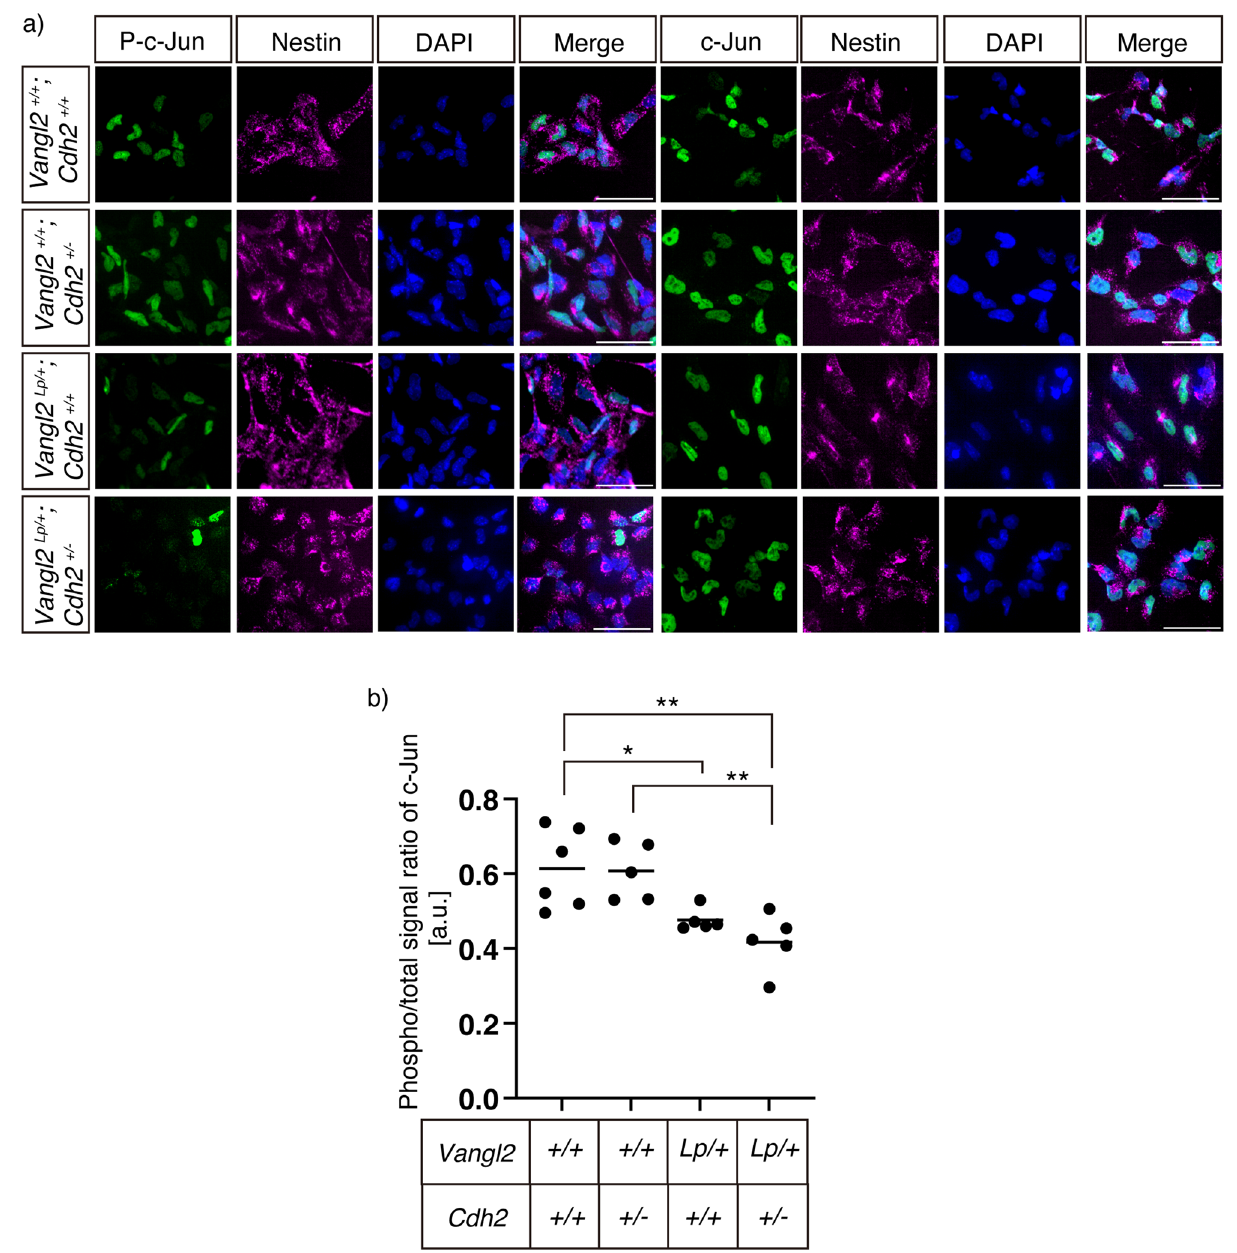
Figure 5. JNK signaling activity in neuroepithelial cells. ( a ) Immunofluorescence analysis of the primary neural tube cells derived from E9.5 embryos with the indicated genotypes. Cells were immunostained with either a combination of anti-phospho c-jun (green) and anti-Nestin (neural cells; magenta) or anti-c-jun (green) and anti-Nestin (magenta). Nuclei were stained with DAPI (blue). ( b ) Point graph showing ratio of immunofluorescent signals of phosphorylated c-Jun to those of the total in the Nestin-positive neuroepithelial cells. The phospho-levels were not significantly different between Vangl2 Lp/+ ; Cdh2 + / + and Vangl2 Lp/+ ; Cdh2 + /− cells, although the levels for both embryos were lower than those of the wild type or Vangl2 + / + ; Cdh2 + /− cells. The solid line indicates the mean (n = 5). Significant differences between groups were calculated using Tukey’s multiple comparison test (* P < 0.05 or ** P < 0.01). Scale bars: 50